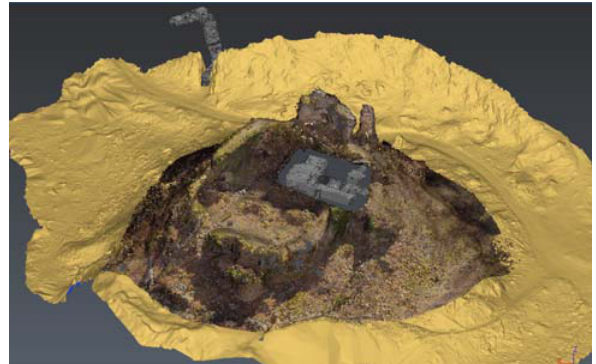
Figure 3: Ruins of castle and environment (DTM).